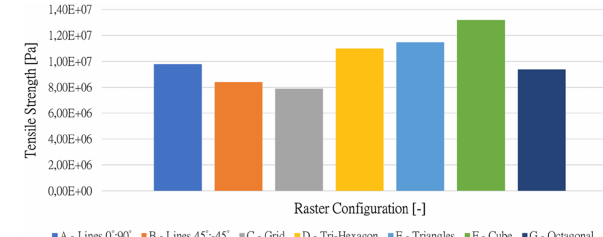
Figure 4: HBP (cid:114) specimen F5(30): (a) Acrylic layer applied (b) STEP 1 (starting test); (c) STEP 51 (collapse condition); (d) Distance to best